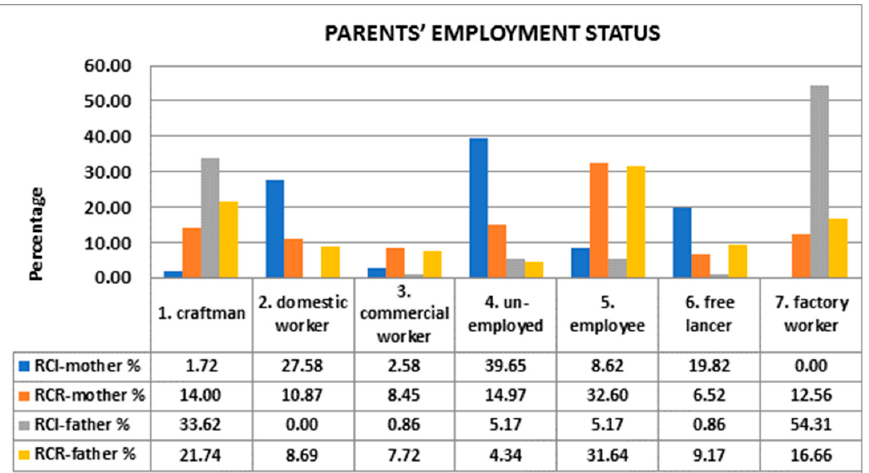
Figure 1. Comparison between parents’ employment statuses.